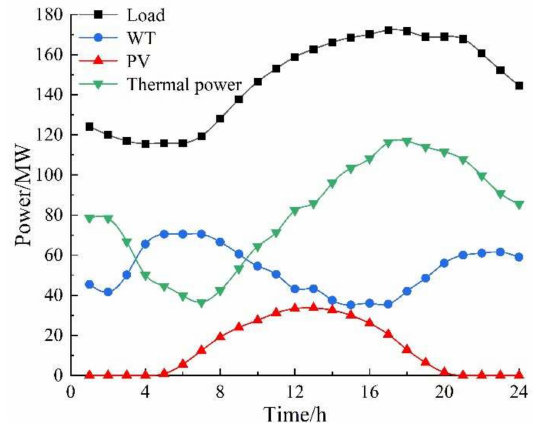
Figure 13. Typical daily power curve for scenario